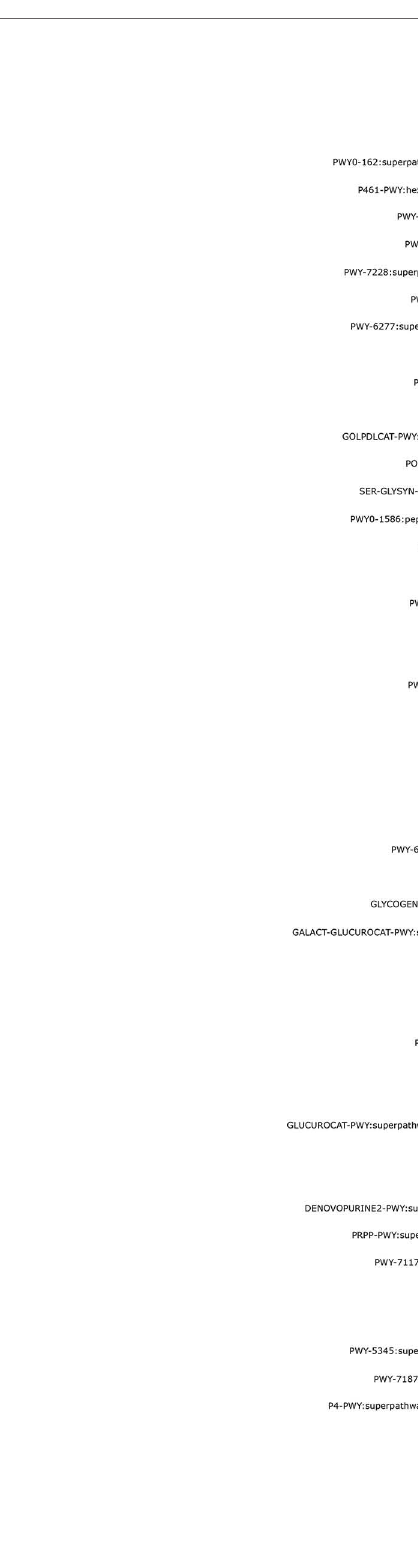
FIGURE 4 | Functional shifts in bacterial species between smokers and non-smokers. Fifty-two pathways differed signi fi cantly, and 32 were enriched in smokers ( P corrected <